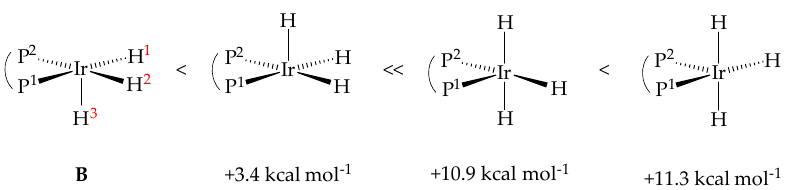
Figure 7. IrH 3 L configurations and their free energies relative to B in acetic acid.